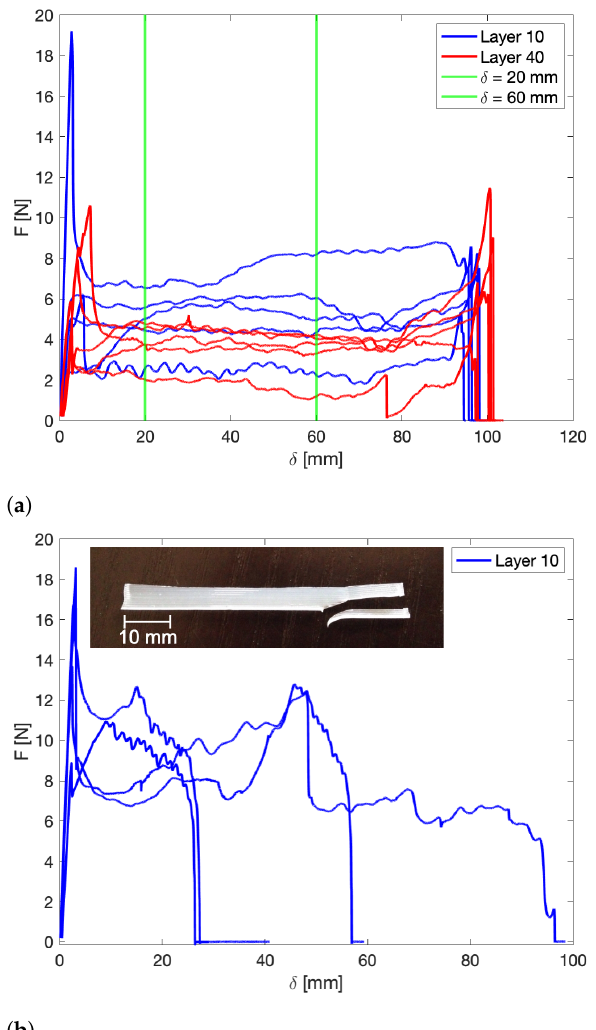
Figure A7. Raw data of load F [N] versus displacement δ [mm]. ( a ) Both studied weld interfaces for Condition 1: HMWPA, T liquefier = 260 °C, v print = 11 mm/s and T build plate = 110 °C. ( b ) The weld interface between layers 9 and 10 for Condition 6: LMWPA, T liquefier = 240 °C, v print = 11 mm/s and T build plate = 110 °C.